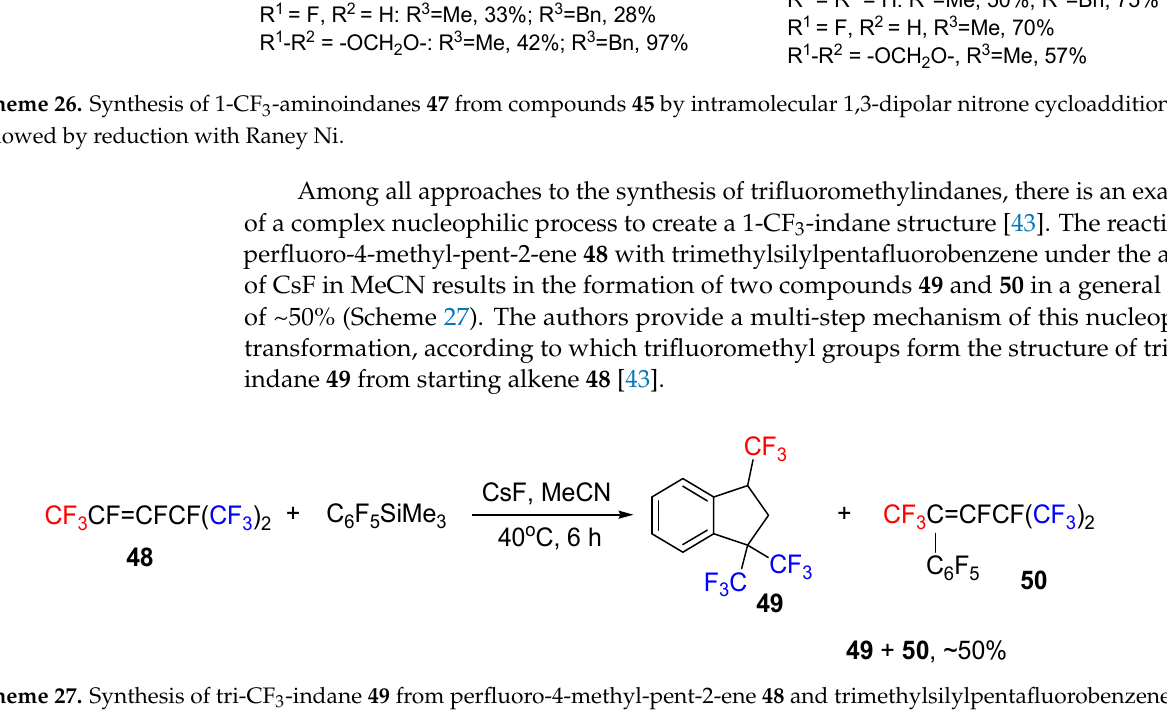
Scheme 27. Synthesis of tri-CF 3 -indane 49 from perfluoro-4-methyl-pent-2-ene 48 and trimethylsilylpentafluorobenzene under the action of CsF in MeCN.